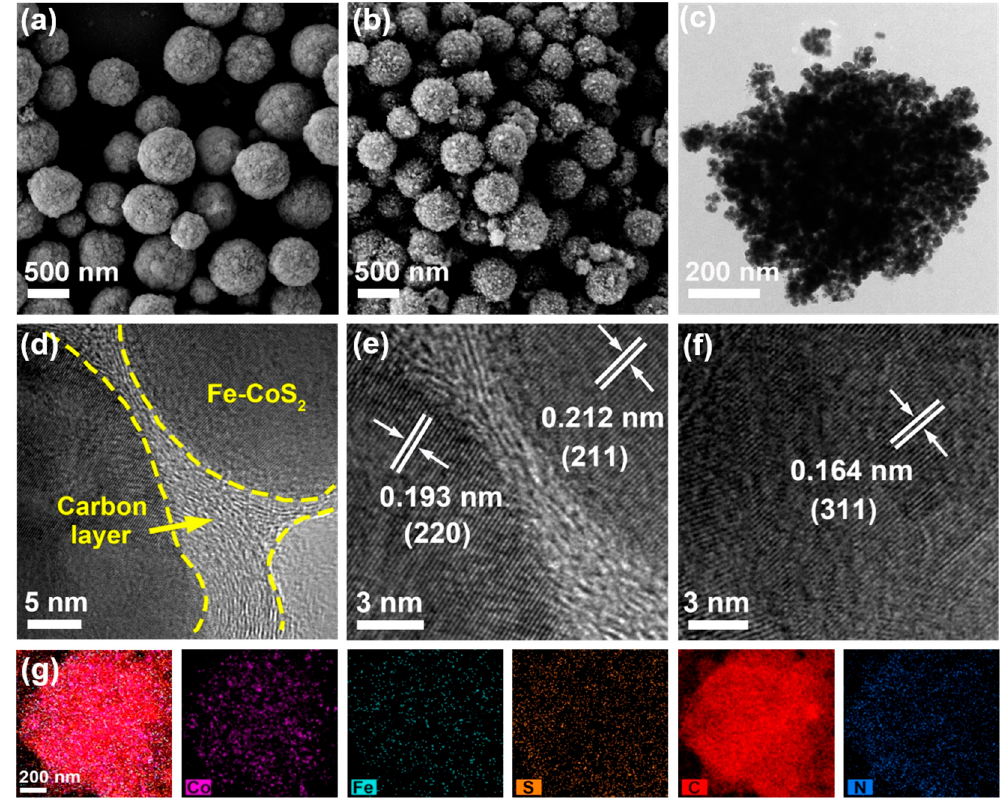
Figure 2. Typical SEM images of the ( a ) FeZnCo-PBA-3 precursor spheres and ( b ) Fe-CoS 2 /NC-3 hybrid spheres, ( c ) TEM image of an individual Fe-CoS 2 /NC-3 hybrid sphere, ( d – f ) HRTEM images, and ( g ) EDS element mapping analysis of Fe-CoS 2 /NC-3.